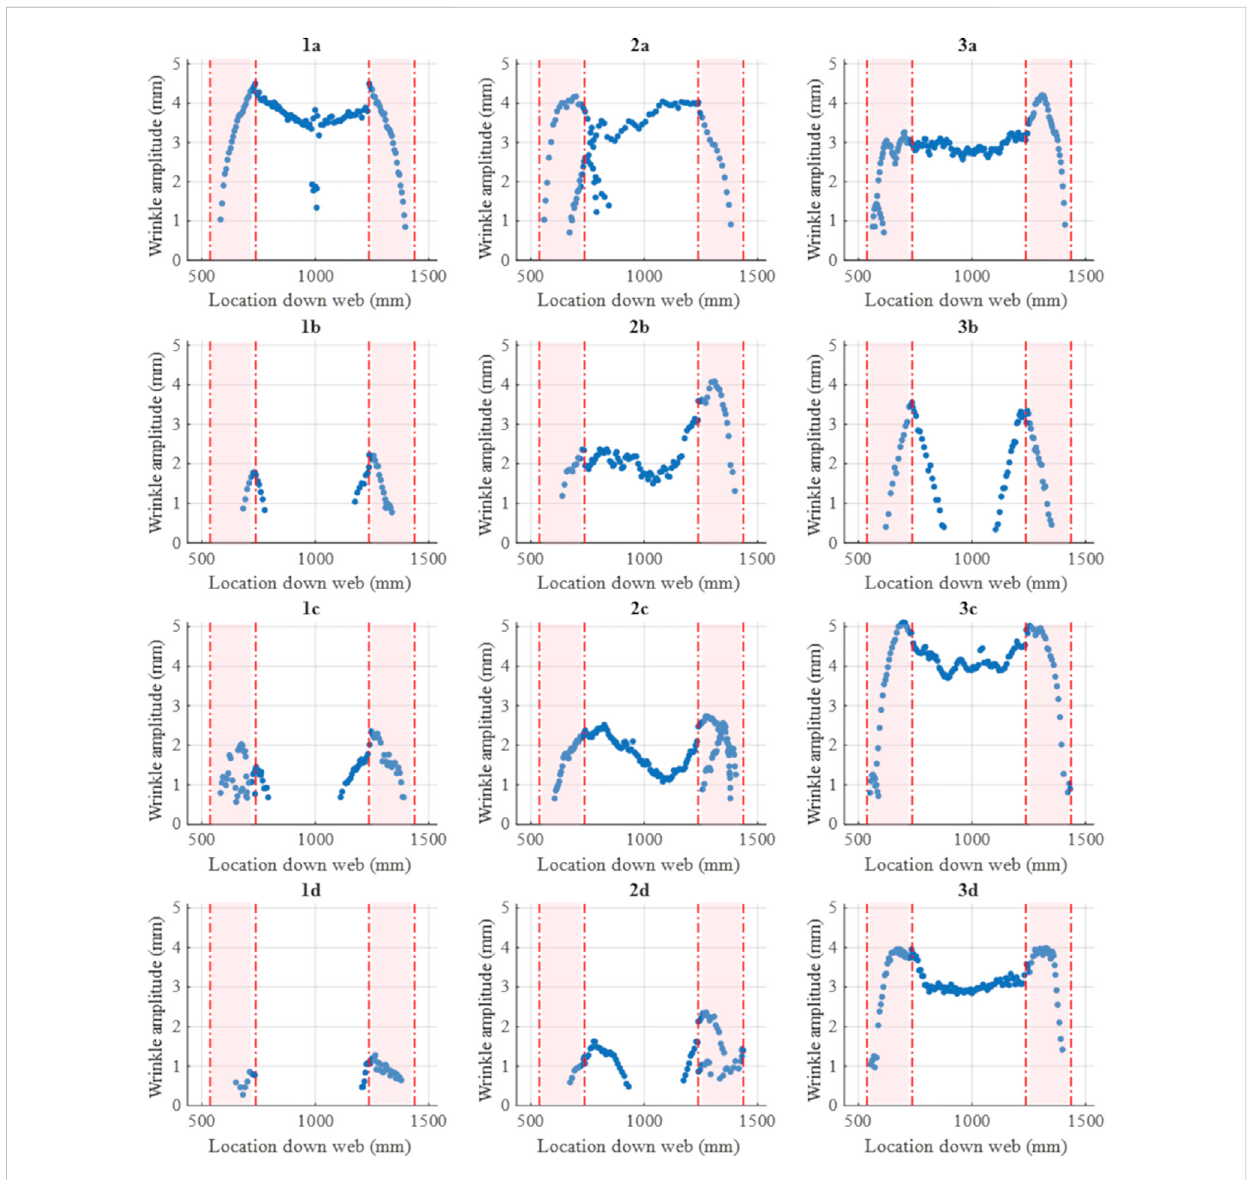
FIGURE 6 Wrinkle amplitude vs. location along web showing location of